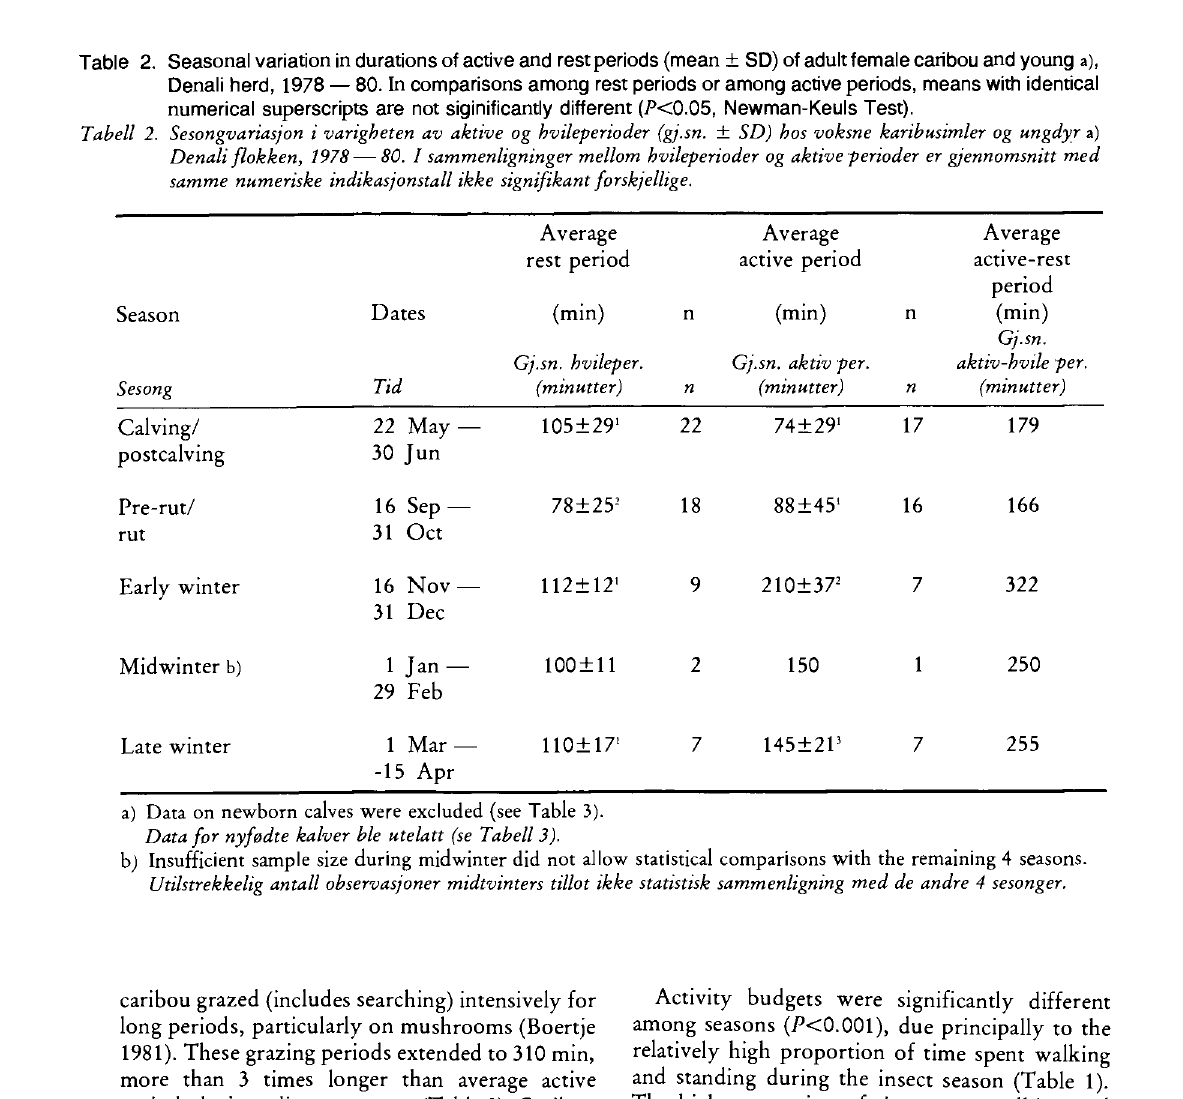
Table 2. Seasonal variation in durations of active and rest periods (mean ± SD) of adult female caribou and young a), Denali herd, 1978 — 80. In comparisons among rest periods or among active periods, means with identical numerical superscripts are not siginificantly different (P<0.05, Newman-Keuls Test). Tabell 2. Sesongvariasjon i varigheten av aktive og hvileperioder (gj.sn. ± SD) hos voksne karibusimler og ungdyr a) Denali flokken, 1978 — 80. I sammenligninger mellom hvileperioder og aktive perioder er gjennomsnitt med samme numeriske indikasjonstall ikke signifikant